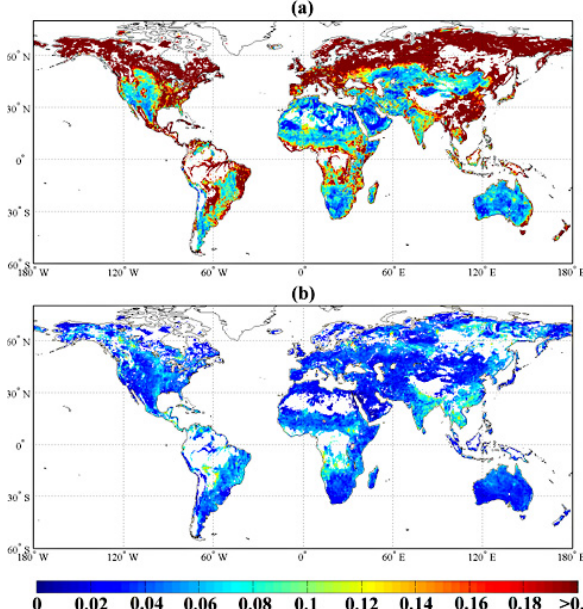
Fig. 5. The root mean square error (RMSE) between Noah and (a) original and (b) rescaled AMSR-E soil moisture estimates (Unit: m 3 m − 3 )